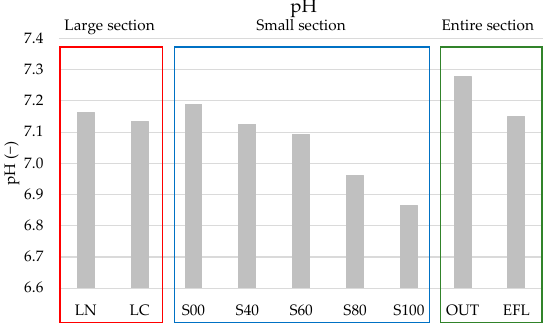
Figure 10. Average pH for each section. In the large section, the mean pH value of LC was lower than that of LN, but the difference was not significant (degrees of freedom = 52, p = 0.12). In the entire section, the mean pH value of EFL (pH = 7.15) was lower than that of OUT (pH = 7.28), and the difference was significant (degrees of freedom = 52, p < 0.0001, effect size d = combination with low EFL/all combinations = 22/27 = 0.81). The Friedman test was performed for the five groups of small sections, and a significant difference was found between some groups ( p < 0.0001). Next, the matrix of p -values was obtained by the Wilcoxon signed-rank test, comparing five groups ( n = 27, 10 combinations). The p *-values after Bonferroni correction were calculated by multiplying the p -values by the number of combinations (Table 3). There was no significant difference between S00 and S40 ( p * = 0.238), but there was a significant difference between S00 and S60 ( p * = 0.012), S80 and S100 ( p * < 0.001). A clear decrease in pH was observed with more than 60% shading. These results indicate that there is no relationship between the shading effect and the decrease in algal growth (increase in IC), but there is a clear relationship between the shading effect and the suppression of alkalization.